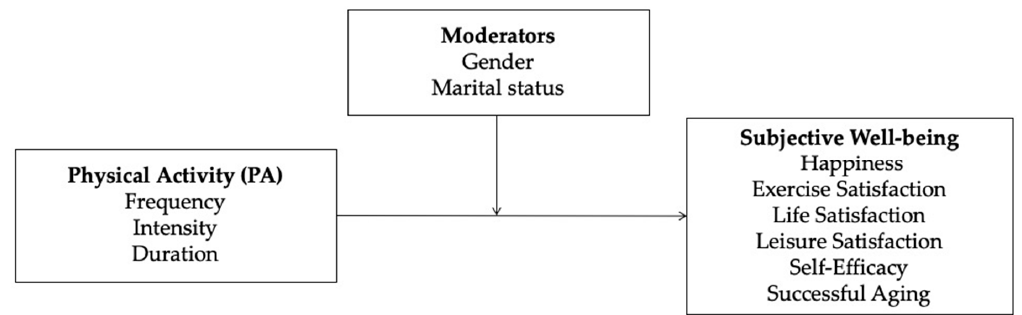
Figure 1. Research model.